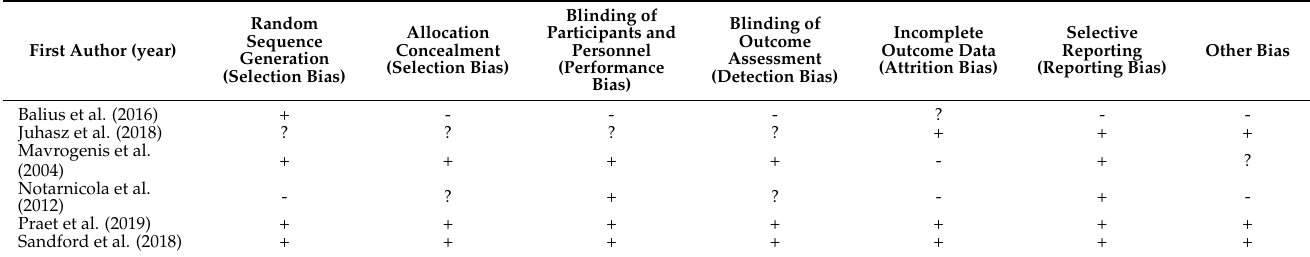
Table 3. Risk of bias assessment for RCTs according to the Cochrane Risk of Bias Tool.